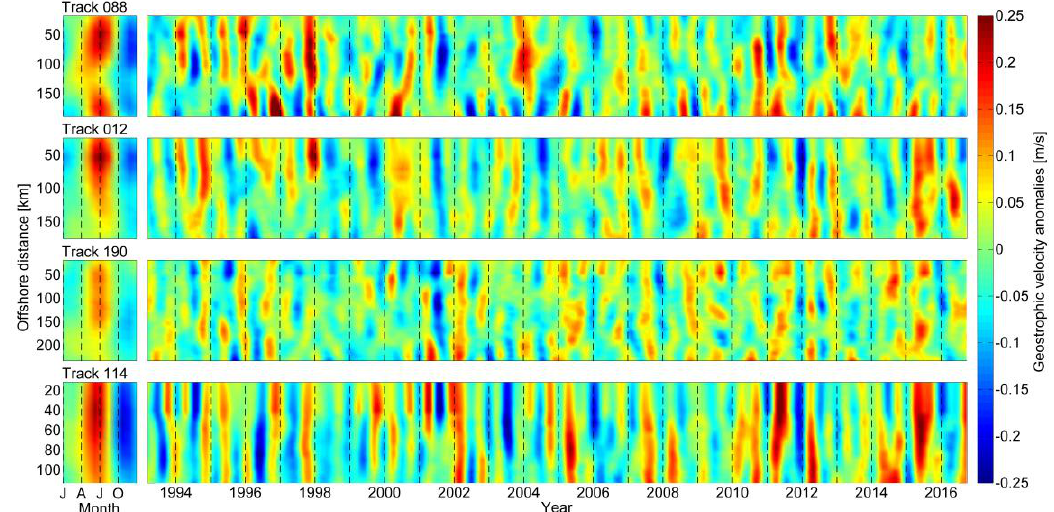
Figure 4. Seasonal cycles (left column) and interannual variabilities (right column) in geostrophic velocity anomalies across four ground tracks. Positive or negative values represent flow towards the northeast or southwest directions, respectively. Track numbers are shown in the upper left corner of left column panels.